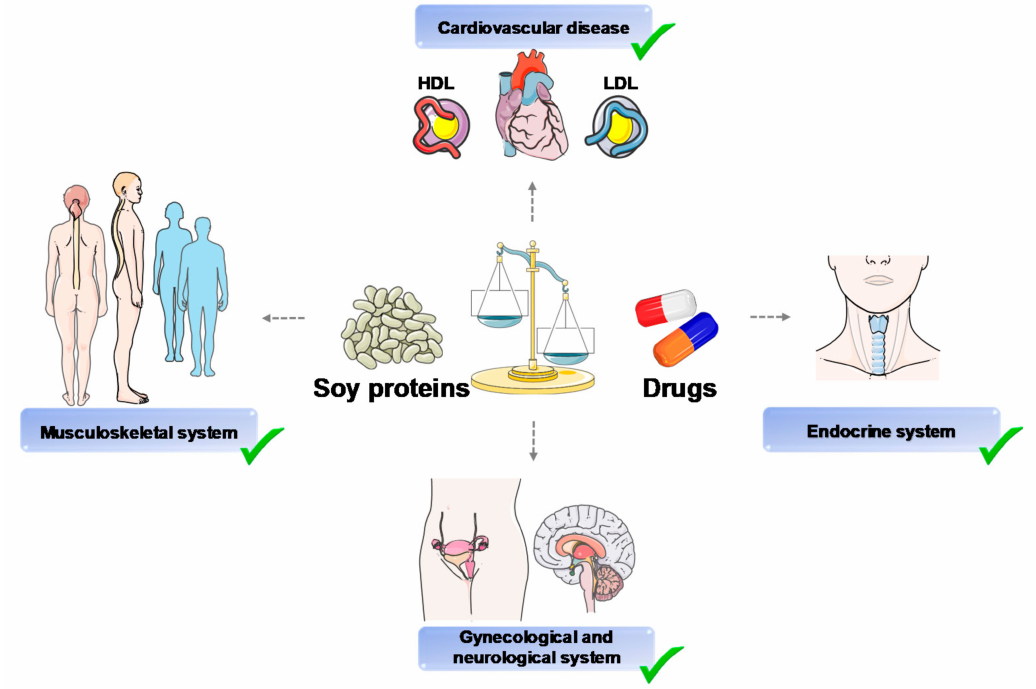
Figure 6. Summary of main healthy benefits of soy proteins. Abbreviations: HDL, high-density lipoprotein; LDL, low- density lipoprotein. Images freely available from Servier Medical